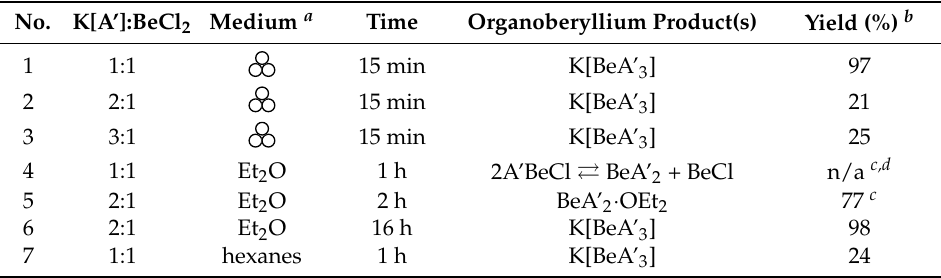
Table 1. Summary of K[A’] and BeCl 2 reactions; amounts of reagents given as molar ratios.